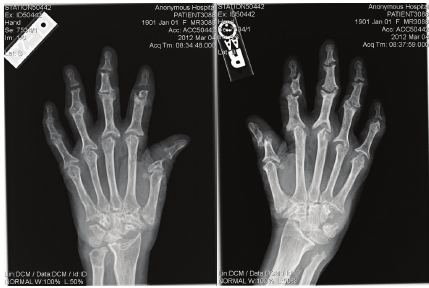
Figure 2: X-ray of the hand showing the “pencil-in-cup” phe- nomenon and narrowing of the joint spaces.